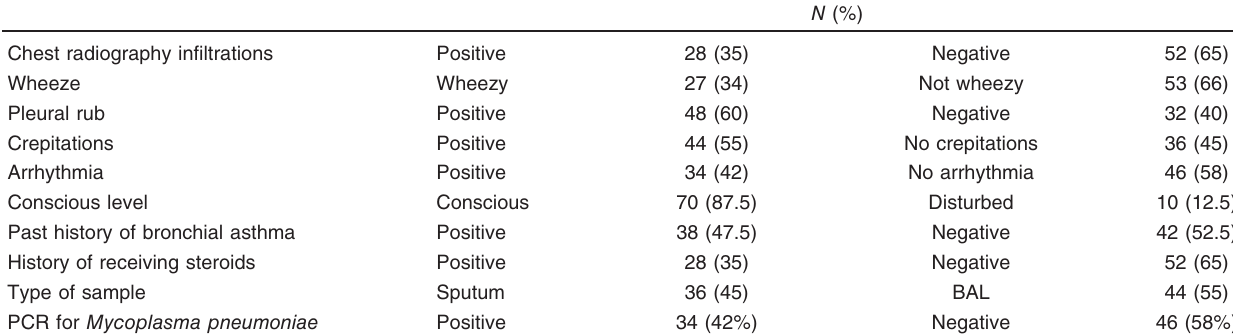
Table 2 Percentage in the studied group according to each of clinical characters and investigations